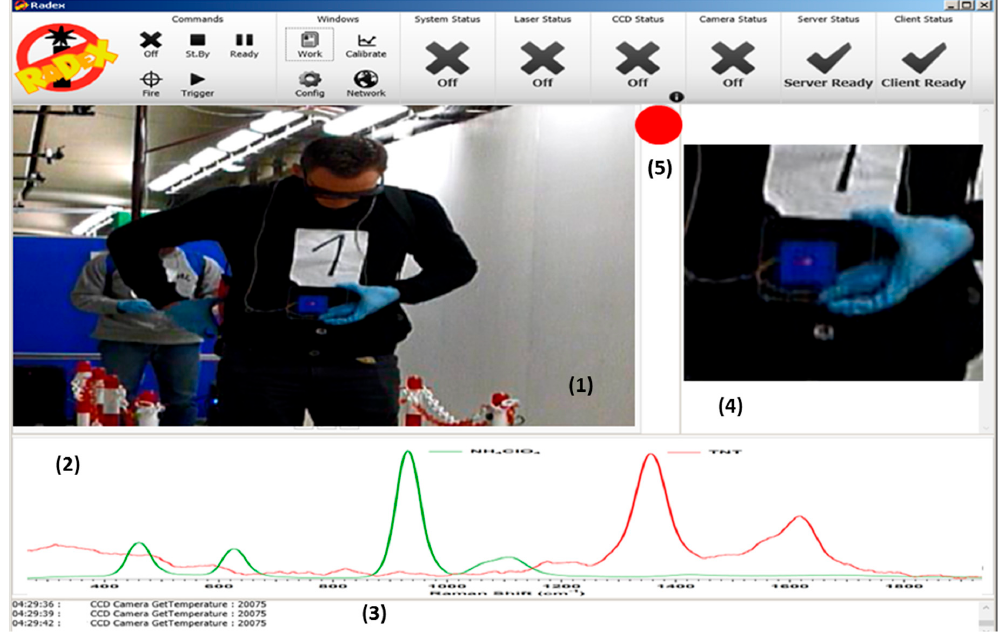
Figure 5. Layout of the RADEX acquisition software: streaming video centered on the point to analyze ( 1 ); the acquired Raman spectrum ( 2 ); the logging data and messages to the operator ( 3 ); the small field of view camera snapshot of the analyzed area ( 4 ); and the real time result of the analysis in form of a traffic light showing the alarm level ( 5 ).